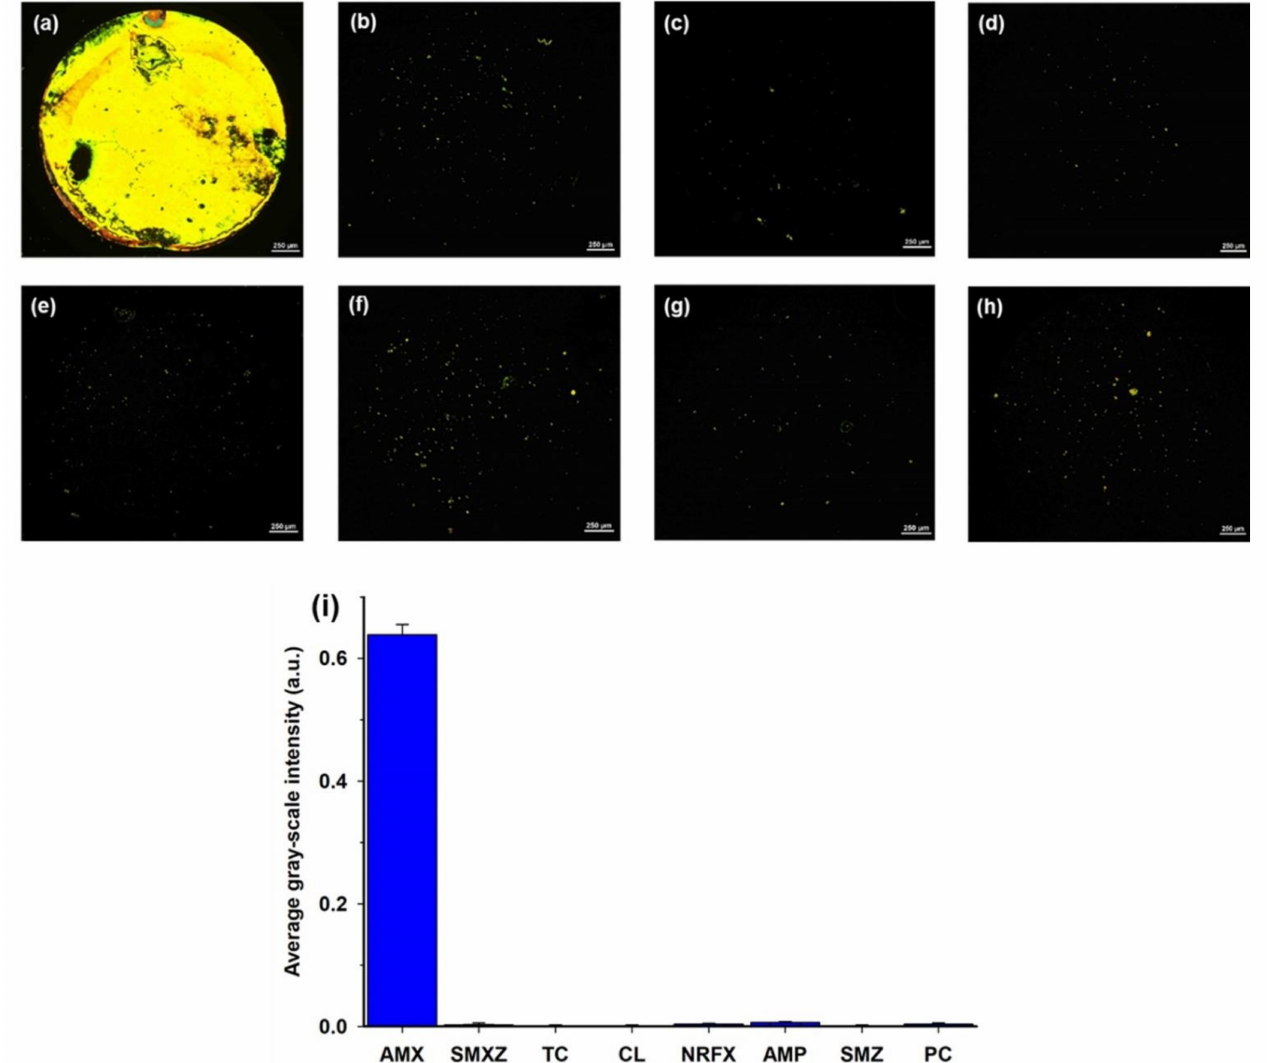
Figure 6. POM images of LC cells in which the bottom glass substrates were incubated with different antibiotic solutions: ( a ) 0.8 µ M AMX; ( b ) 1 µ M SMXZ; ( c ) 1 µ M TC; ( d ) 1 µ M CL; ( e ) 1 µ M NRFX; ( f ) 1 µ M AMP; ( g ) 1 µ M SMZ; and ( h ) 1 µ M PC. ( i ) Average GI of optical images caused by amoxicillin (0.8 µ M) and other control antibiotics (1 µ M). Scale bar, 250 µ